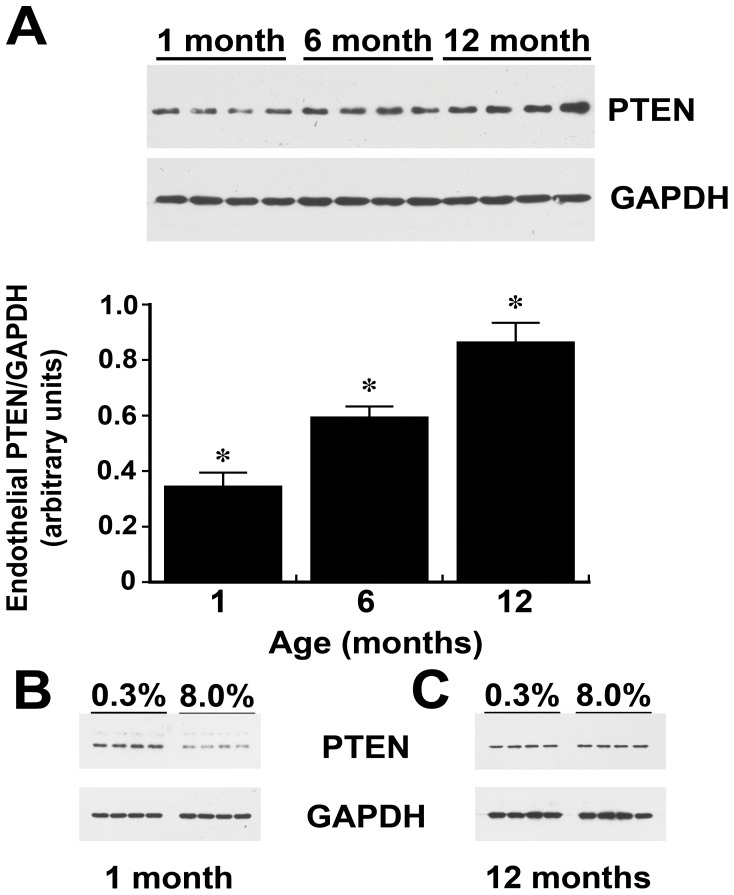
Endothelial PTEN levels increase with age and become refractory to change.(A) Western blot showing increases in endothelial PTEN levels with aging. The graph shows the mean density of the bands relative to GAPDH. n = 4 rats in each group. *p-value <0.05 compared to the other two groups (B) Endothelial PTEN levels of one-month old rats on 0.3% and 8.0% NaCl diets. Endothelium from rats on the low-salt diet had greater amounts of PTEN relative to GAPDH than endothelium from rats the same age on the high-salt diet (0.56±0.03 versus 0.17±0.01; p-value <0.05). (C) Endothelial PTEN levels of 12-month old rats on 0.3% and 8.0% NaCl diets. In this analysis, endothelium from rats on the low-salt and high-salt diets had comparable amounts of PTEN relative to GAPDH (0.072±0.002 versus 0.074±0.001; p-value = 0.422).